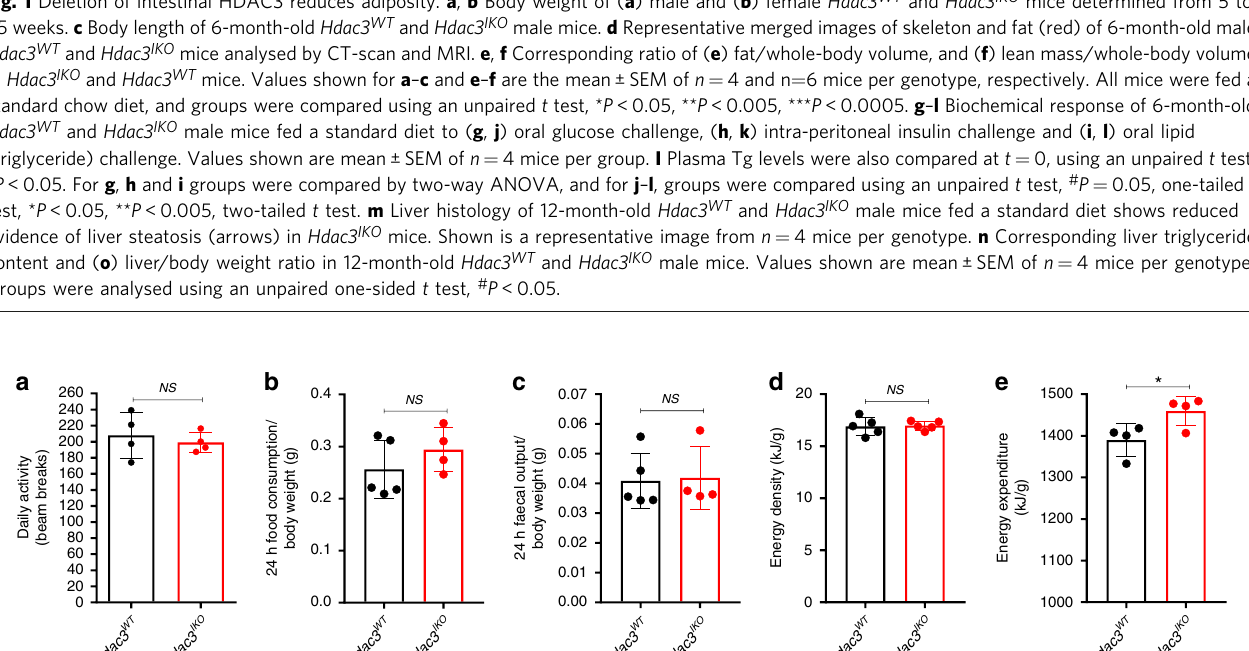
Fig. 1 Deletion of intestinal HDAC3 reduces adiposity. a , b Body weight of ( a ) male and ( b ) female Hdac3 WT and Hdac3 IKO mice determined from 5 to 85 weeks. c Body length of 6-month-old Hdac3 WT and Hdac3 IKO male mice. d Representative merged images of skeleton and fat (red) of 6-month-old male Hdac3 WT and Hdac3 IKO mice analysed by CT-scan and MRI. e , f Corresponding ratio of ( e ) fat/whole-body volume, and ( f ) lean mass/whole-body volume in Hdac3 IKO and Hdac3 WT mice. Values shown for a – c and e – f are the mean ± SEM of n = 4 and n = 6 mice per genotype, respectively. All mice were fed a standard chow diet, and groups were compared using an unpaired t test, * P < 0.05, ** P < 0.005, *** P < 0.0005. g – l Biochemical response of 6-month-old Hdac3 WT and Hdac3 IKO male mice fed a standard diet to ( g , j ) oral glucose challenge, ( h , k ) intra-peritoneal insulin challenge and ( i , l ) oral lipid (triglyceride) challenge. Values shown are mean ± SEM of n = 4 mice per group. I Plasma Tg levels were also compared at t = 0, using an unpaired t test,